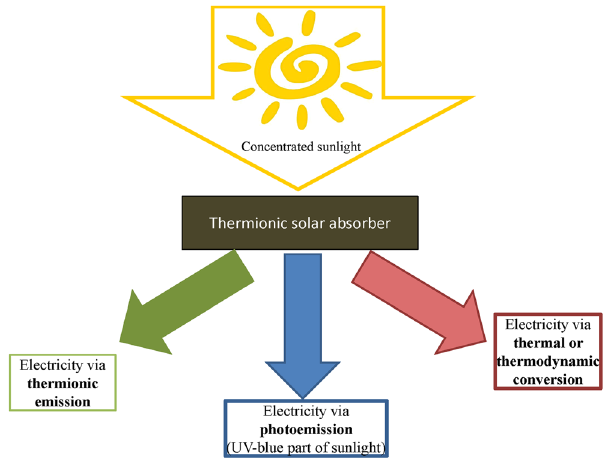
Figure 1. Concept of the thermionic/thermodynamic solar absorber.